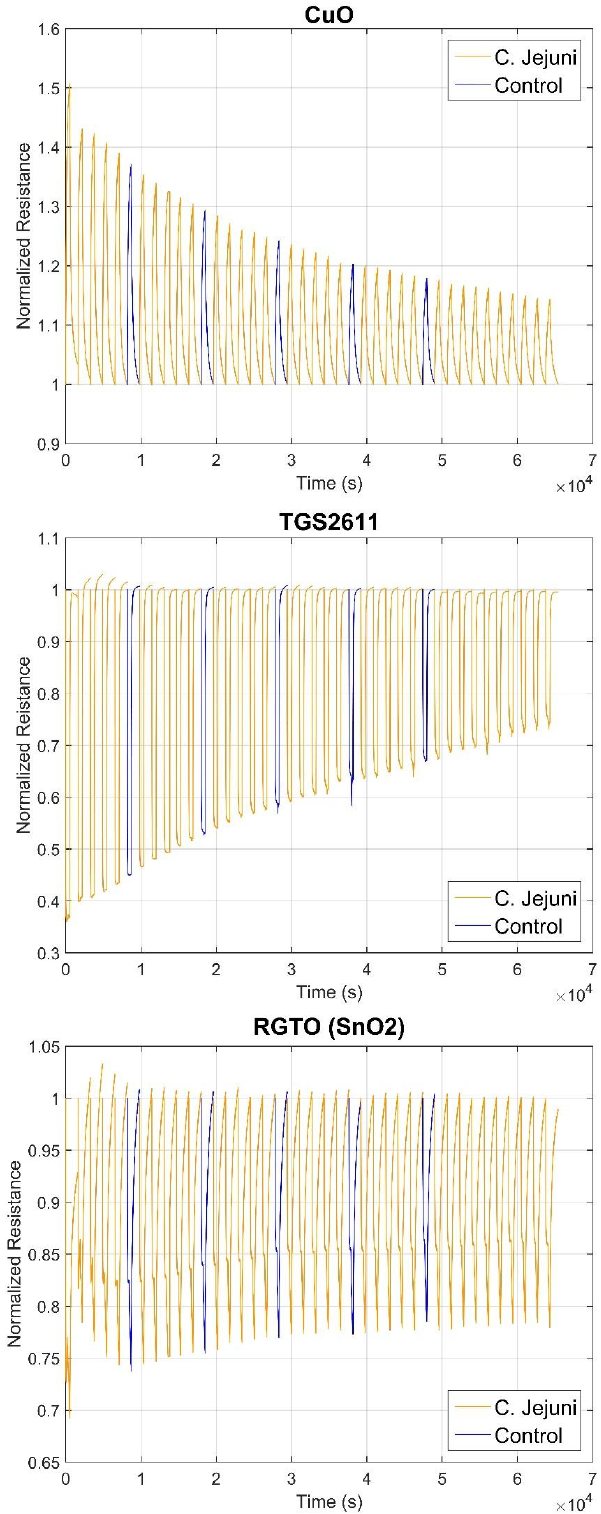
Figure 1. Resistance variations of three sensors once exposed to VOCs. From top to bottom: copper oxide nanowire, TGS2611 and tin oxide Rheotaxial Growth and Thermal Oxidation (RGTO). On the x-axis there is time in seconds, on the y-axis normalized resistance.